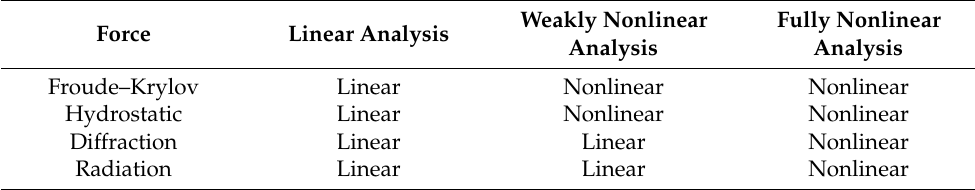
Table 1. Hydrodynamic analysis methods for the floating